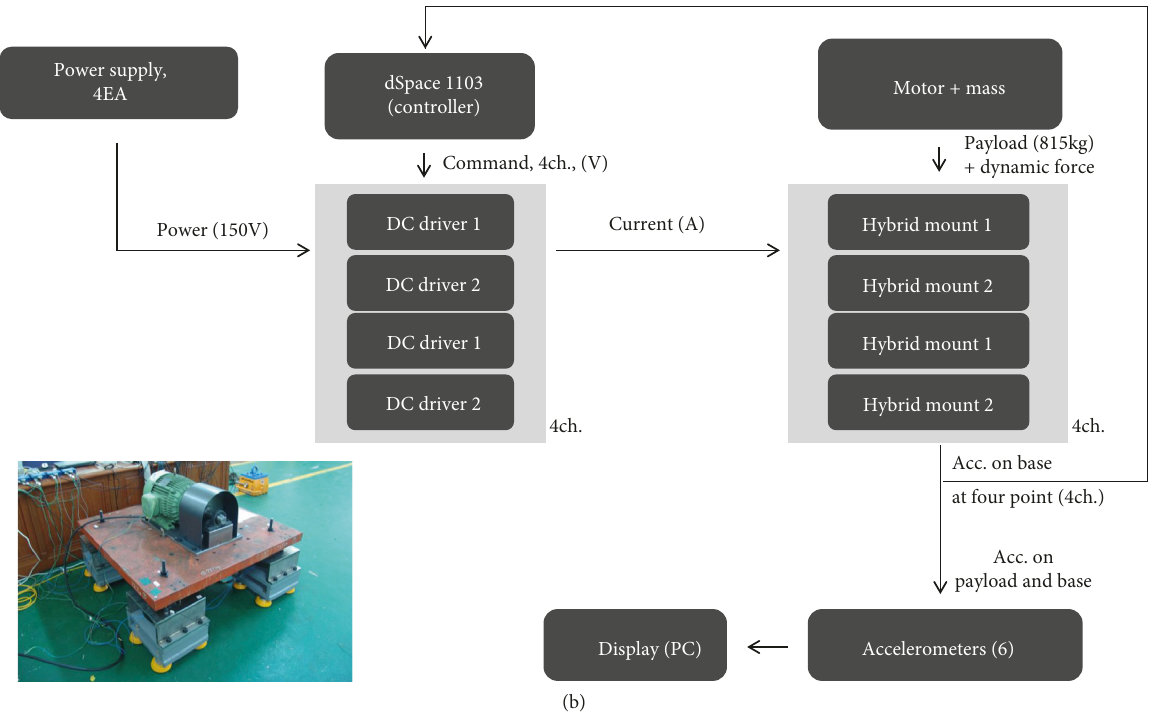
Figure 18: Schematic diagram ofthe experimentalsetup forthe 7-DOF system.(a) Schematic diagram ofthe 7-DOF system. (b)Control scheme.